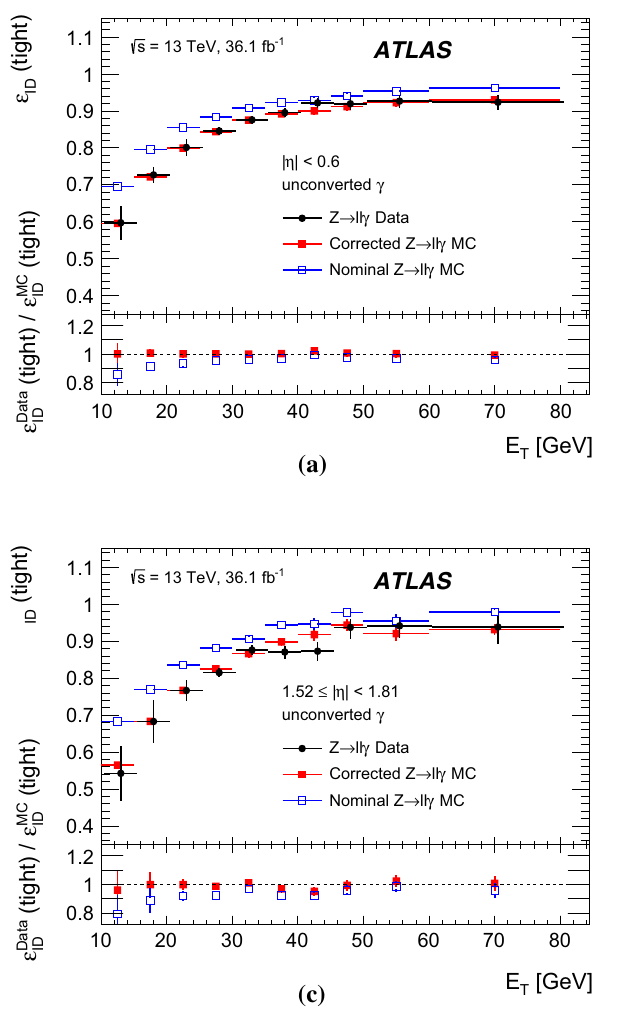
Fig. 9 Comparison of the measurements of the data-driven identifica- tion efficiency for unconverted photons measurements obtained using the radiative Z method with the predictions from Z → (cid:4)(cid:4)γ simu- lation as a function of photon E T , for the four pseudorapidity inter- vals a | η | < 0 . 6, b 0 . 6 ≤ | η | < 1 . 37, c 1 . 52 ≤ | η | < 1 . 81, and d